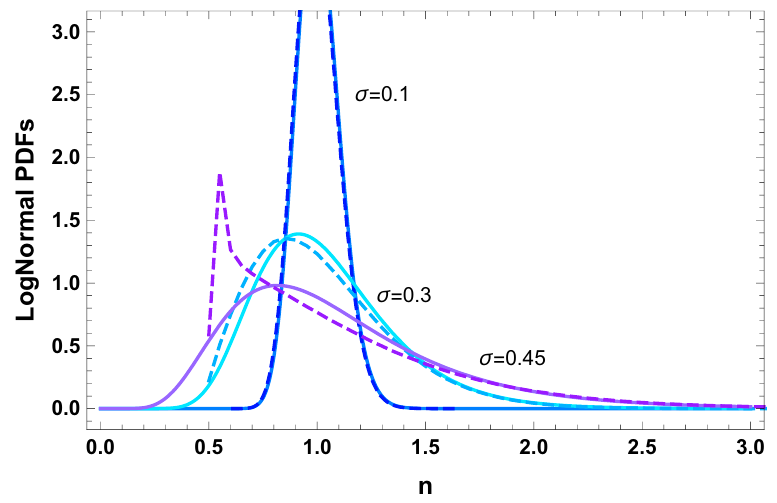
Figure 1 . The log normal PDFs and corresponding normal approximations for (cid:27) = 0 : 1, 0.3 and 0.45 are shown in blue, cyan and purple respectively. Solid curves show the true distributions, dashed curves show the approximate